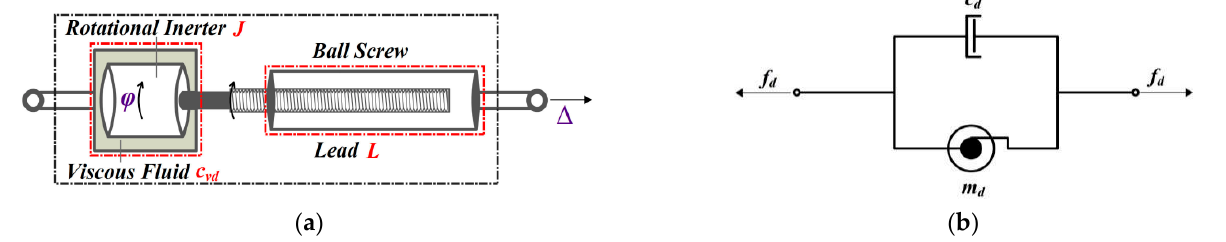
Figure 2. Structure and mechanical model of an inerter viscous damper (IVD): ( a ) Structure of IVD; and ( b ) mechanical model.